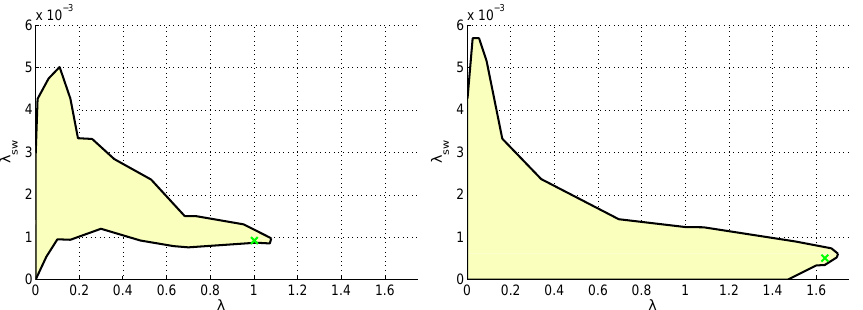
Figure 3. Examples of feasible regions for nominal speed and load ( left ) and for low speed and load ( right ). The optimal solution is shown as a × mark on each region.